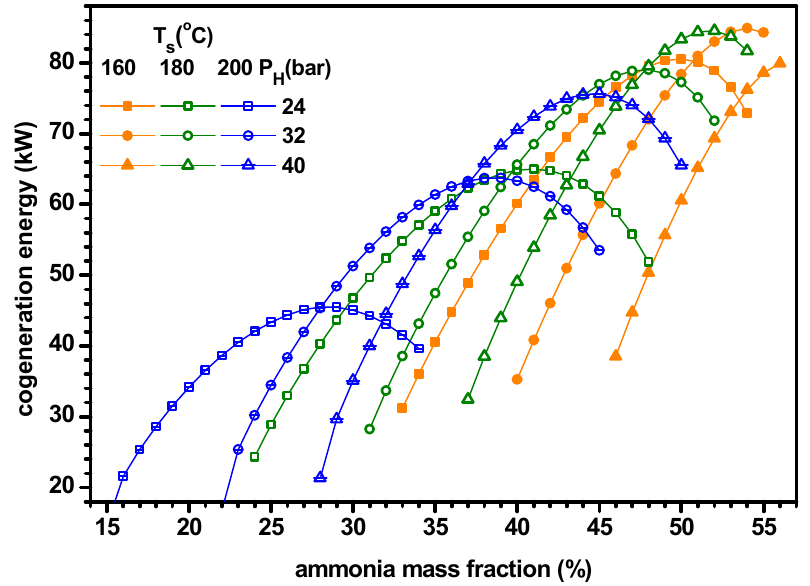
Figure 10. Cooling for varying ammonia fraction.